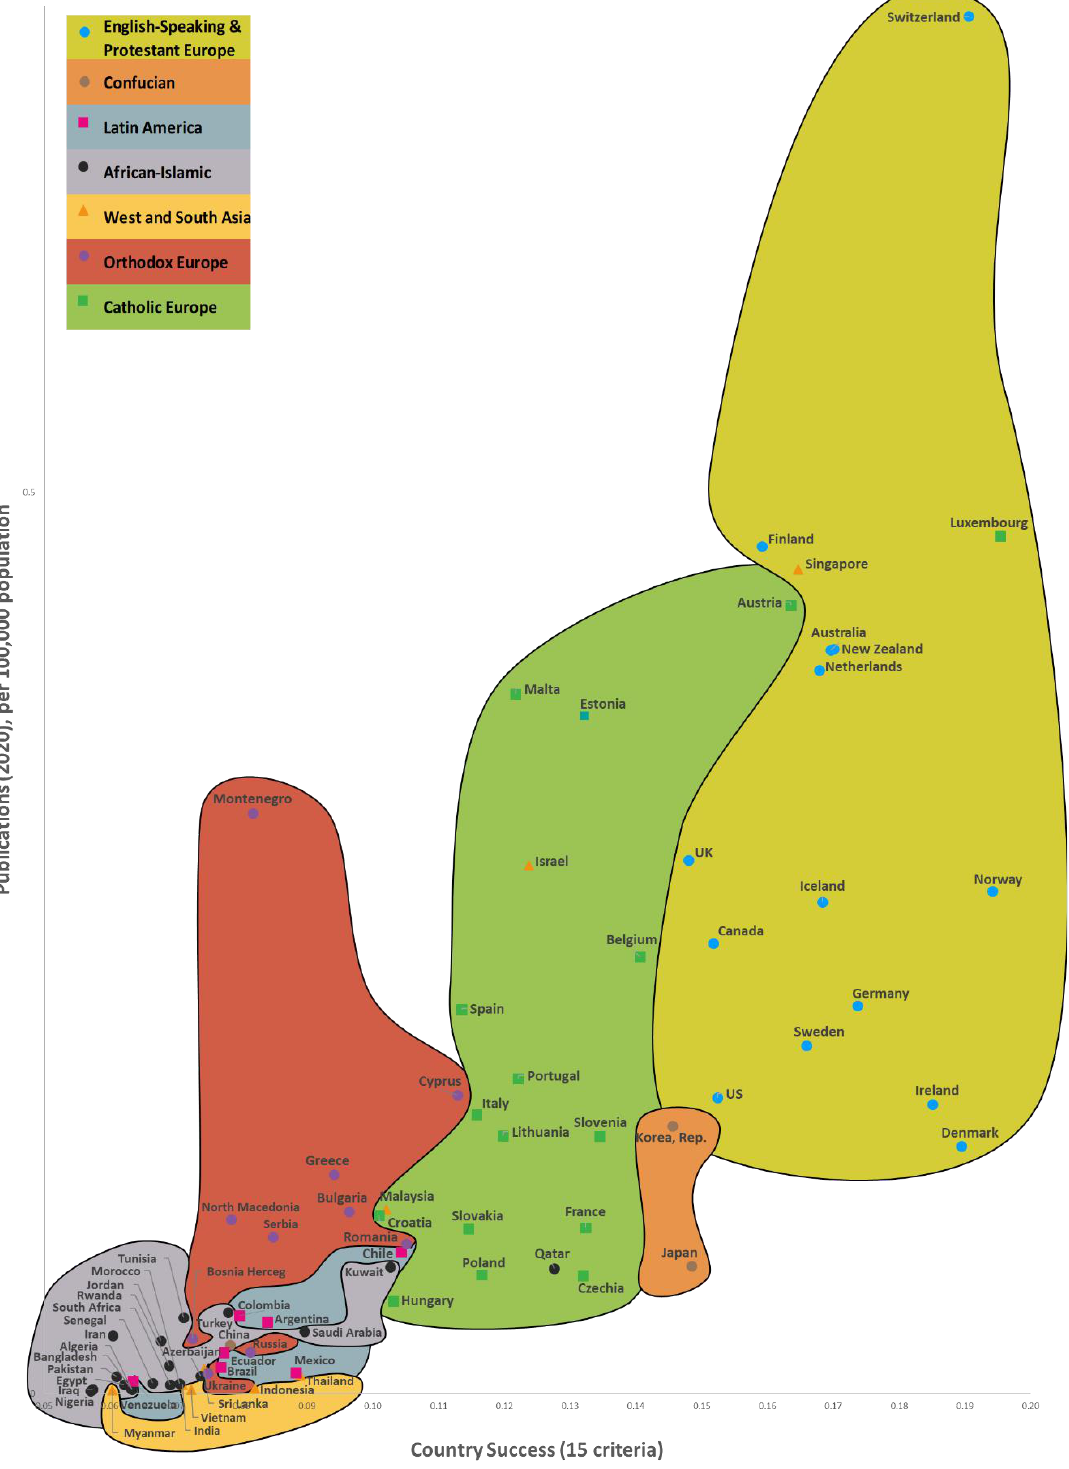
Figure 12. CSP map showing the success of countries in terms of the numbers of publications on AFFECT recognition (CSPN) in Web of Science journals with impact factor.